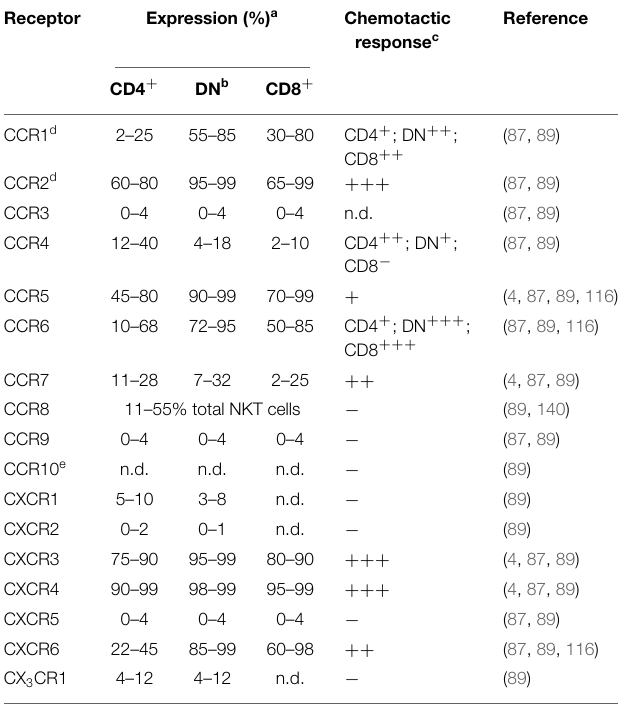
TABLE 1 | Chemokine receptor expression and ligand responses on circu- lating human NKT cells . Receptor Expression (%) a Chemotactic response c